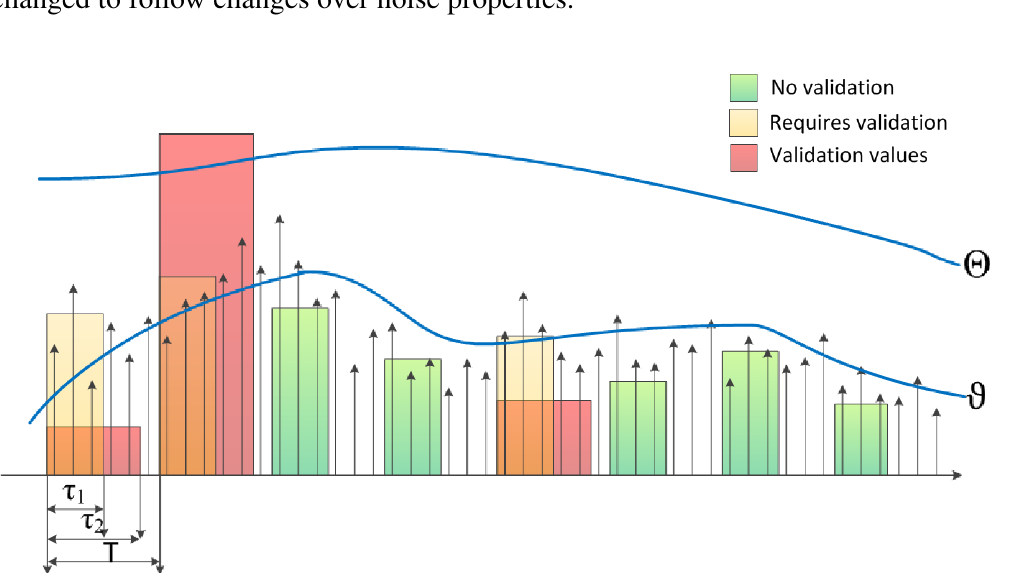
Figure 4. The operation of the Adaptive BACV Algorithm (ABACV). Thresholds ϑ and Θ are changed to follow changes over noise